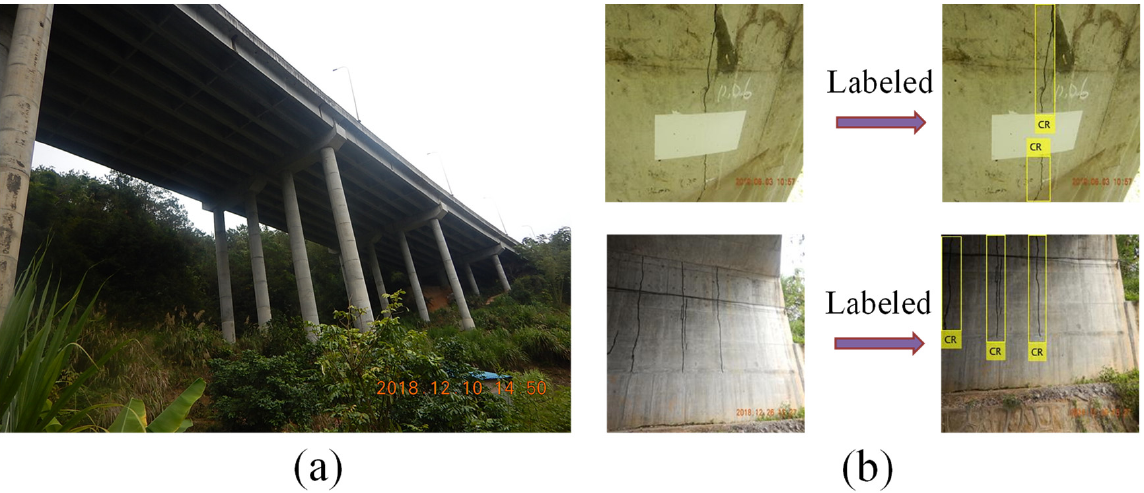
Figure 8. Xinqing viaduct and some labeled images using the ‘Image labeler’ toolbox. ( a ) Bridge appearance; ( b ) image annotation.